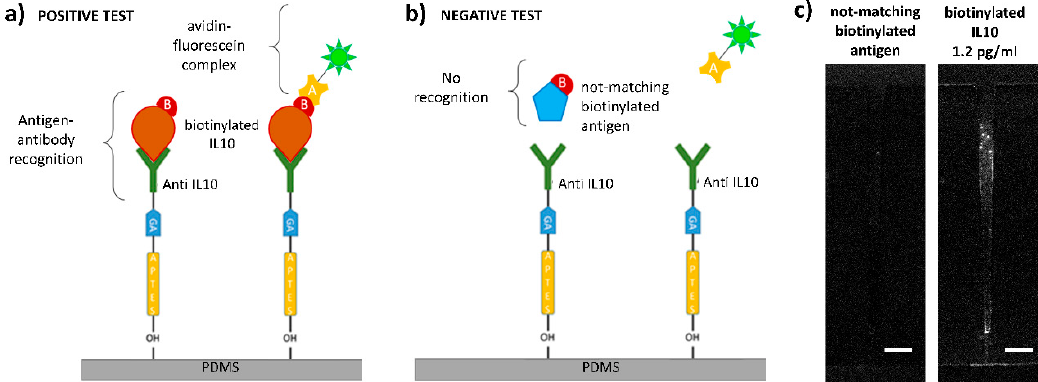
Figure 4. Antigen-antibody recognition mechanism and biosensing experiments. ( a ) Positive test: target biotinylated IL10 antigens in solution recognize and bind to the probe antibodies anchored to the surface; fluorescent avidin binds to the biotin, and it is detected by fluorescence microscopy; ( b ) negative test: biotinylated not-matching antigens do not bind with the probe antibodies, and they are washed away, no fluorescence signal can be detected. ( c ) Epifluorescence microscopy images of the funnel after a positive test performed with a biotinylated IL10 concentration of 1.2 pg / mL (right) and after a negative test (left).